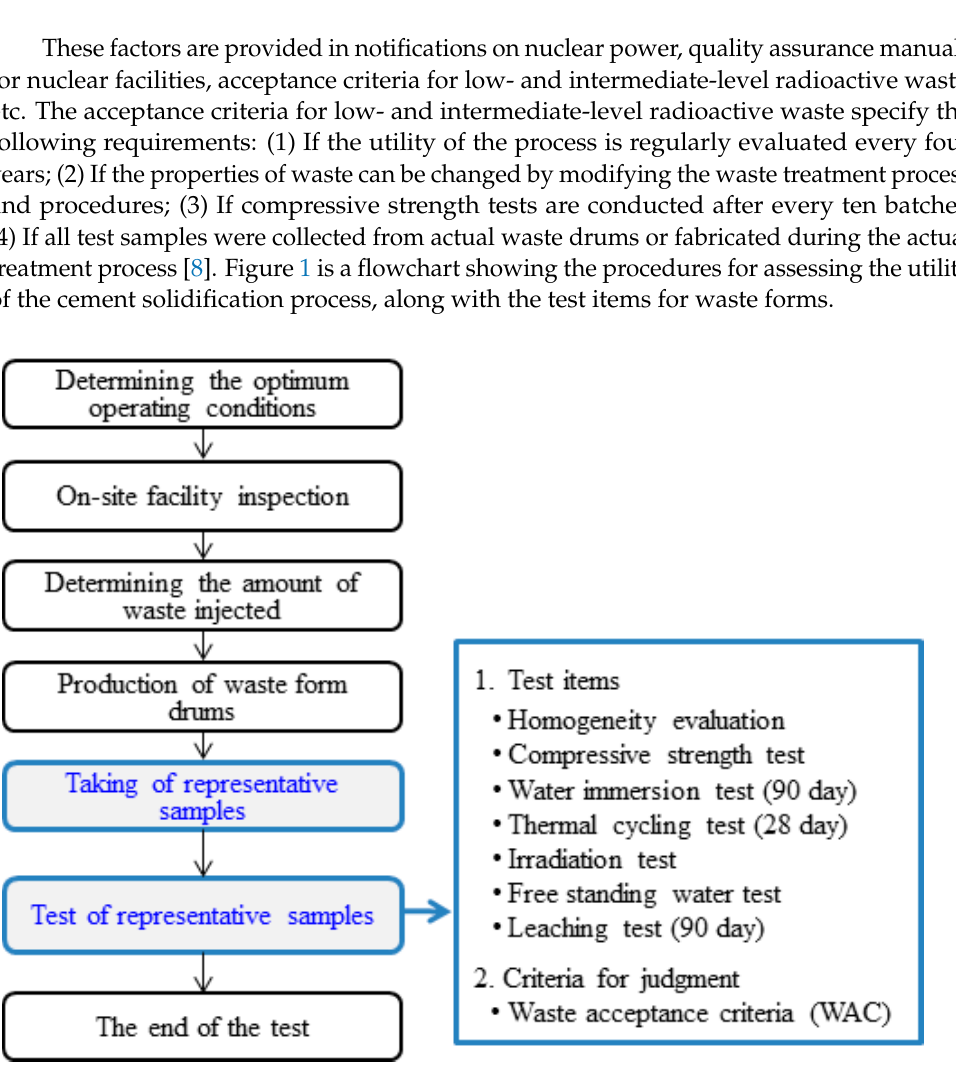
Table 3. Factors to consider when operating a solidification process facility.